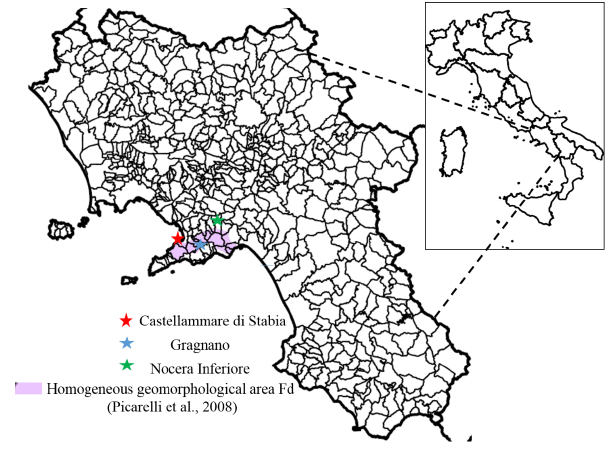
Figure 1. Geographic locations of the three towns considered in the